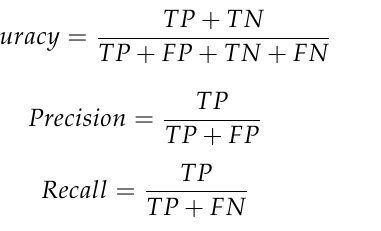
Table 3. Parameters to evaluate inspection results.